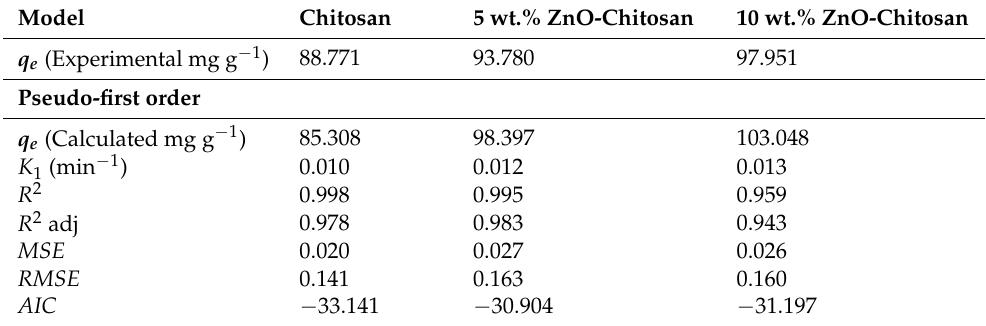
Table 2. Kinetics models for the dye adsorption onto the chitosan and the